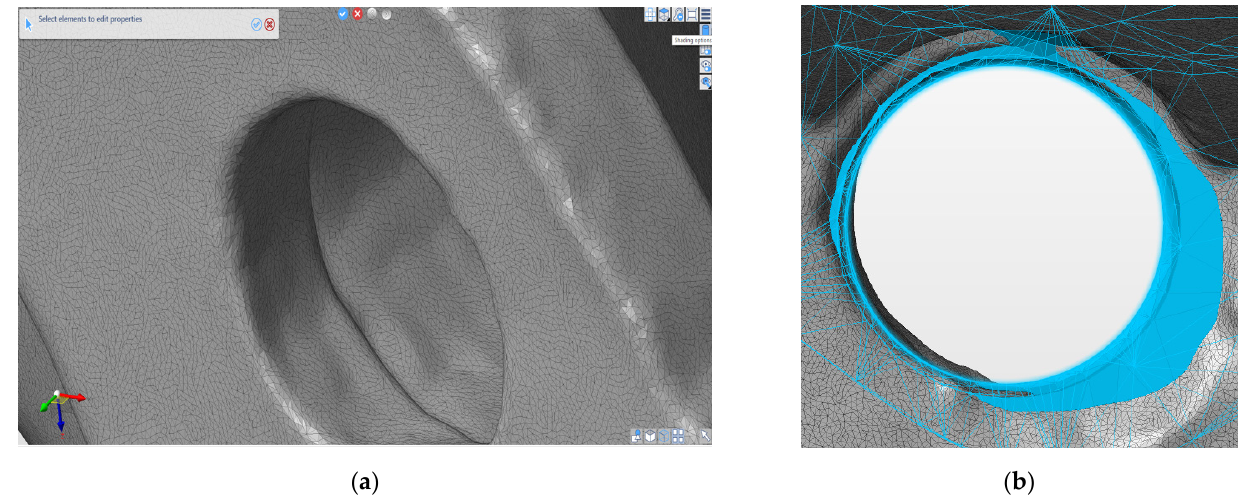
Figure 11. ( a ) 3D scanned hole ( b ) comparative of the corrected hole and the CAD model (overlap between the scanned hole and the original CAD model).